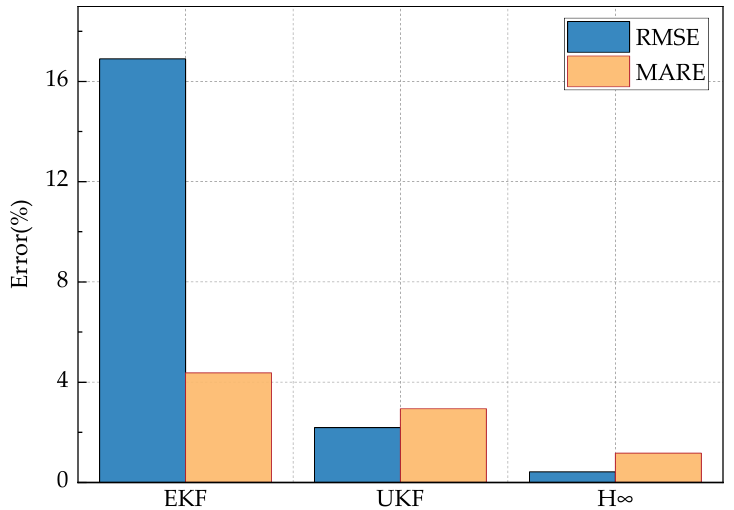
Figure 12. Error of SOC estimation by H ∞ algorithm under UDDS condition.